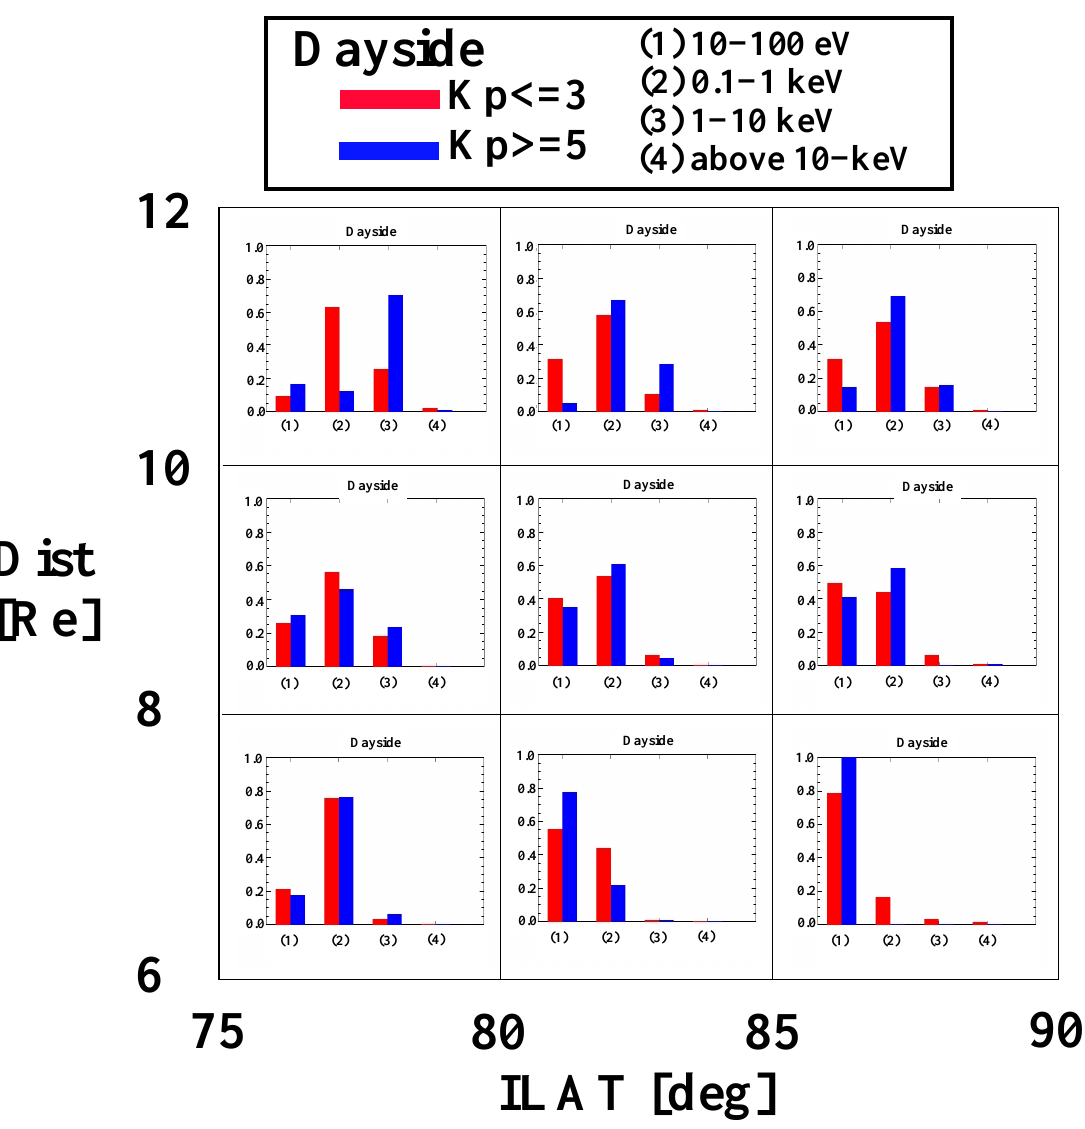
Fig. 3. The occurrence rates of different PE levels in the dayside region showing in each 2 R E × 5 ◦ lattice. The pairs of bars are separated regarding the different PE levels in the horizontal axis (from the left, (1) 10 ≤ PE< 100eV, (2) 0.1 ≤ PE< 1keV, (3) 1.0 ≤ PE< 10keV, and (4) 10keV ≤ PE ) and the colour of bar implies “Quiet” in red and “Active” in blue, according to the K p index. The definition of Quiet/Active is K p ≤ 3/ K p ≥